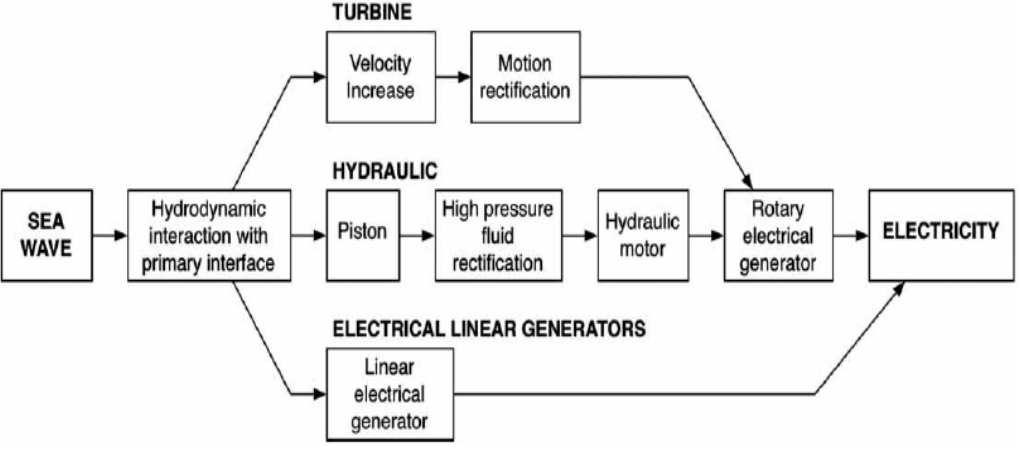
Figure 1. Energy Conversion in WEC [14].